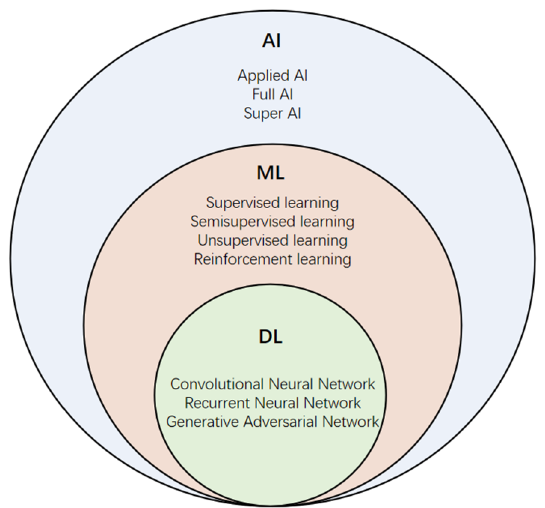
Figure 1. The relationship and main types of AI, ML, and DL.